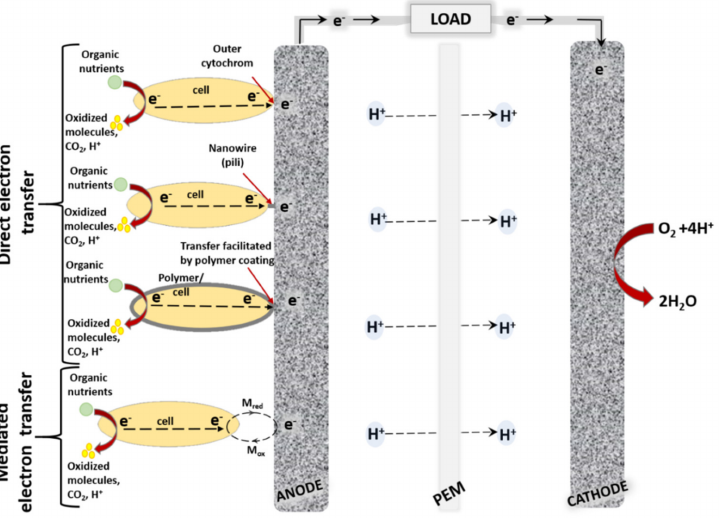
Figure 1. General scheme of microbial biofuel cell with direct and mediated electron